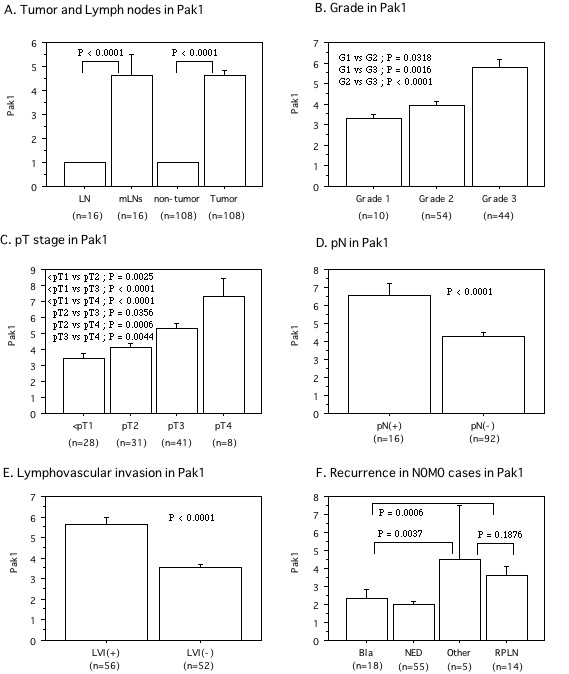
The relative expression levels of Pak1 protein in tumor to those in corresponding non-tumor portion, which was set to 1.0. A; Expression in tumor, non-tumor, and lymph node tissues with metastasis (mLNs) and without (LN). B; Expression in Grade. C; Expression in pT stage. D; Expression in lymph node metastasis. pN(-) is pN0. pN(+) is pN1-3. E; Expression in lymphovascular invasion (LVI). F; Expression in first recurrence site. There were no difference between bladder and none of recurrence. The data show the 95% confidential interval.